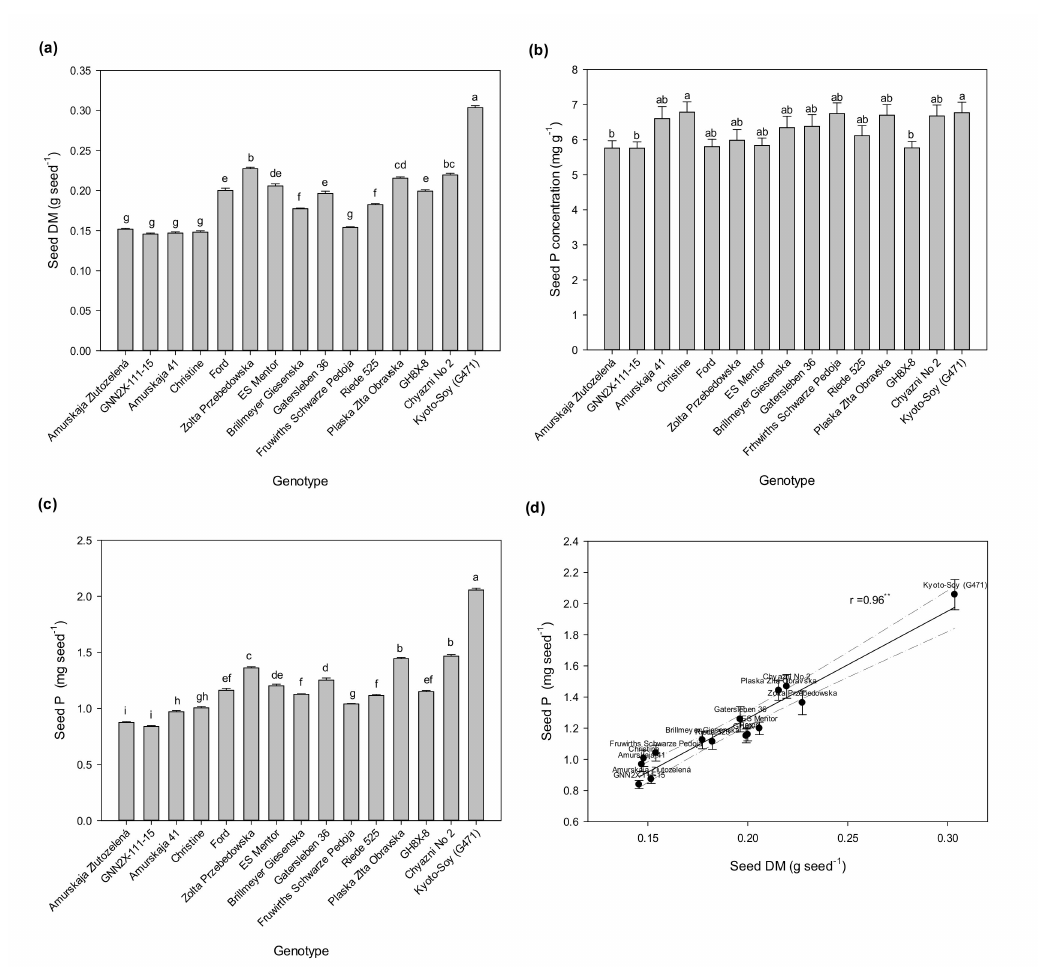
Figure 1. Experiment 1. Seed dry matter (DM) ( a ), seed P concentration ( b ), and seed P content ( c ) among the soybean genotypes. The letters on top of each column represent Tukey’s HSD grouping. Error bars represent standard errors ( n = 6). The linear relationship between seed P content and seed DM is also shown ( d